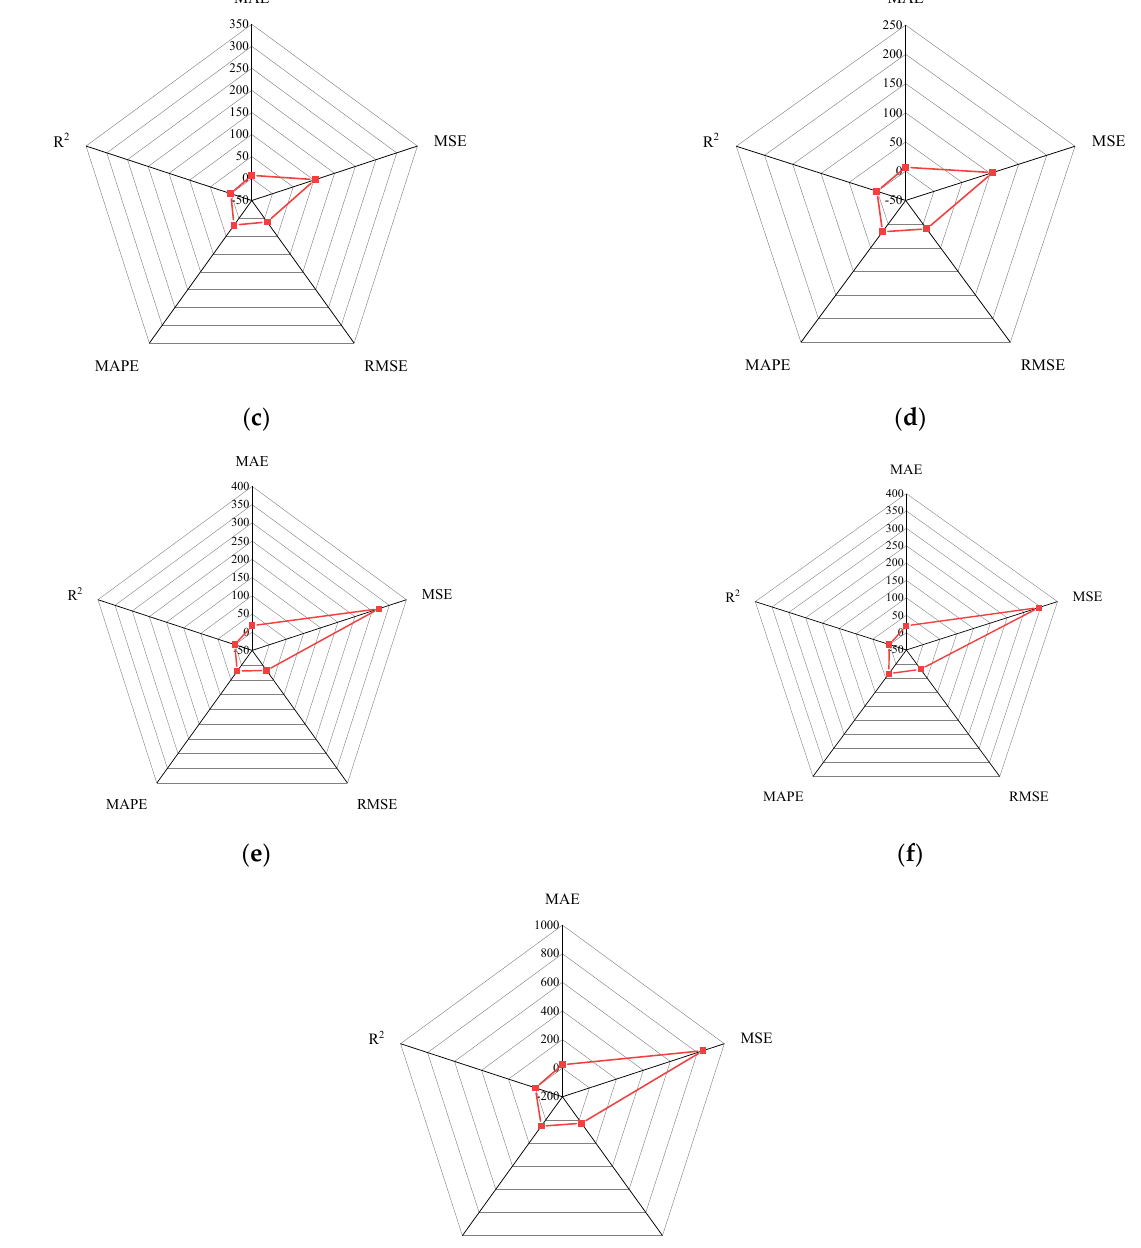
Figure 15. Radar diagram of calculation results. ( a ) BP neural network; ( b ) GA-BP neural network; ( c ) Optimized BP neural network; ( d ) Optimized GA-BP neural network; ( e ) ACI-318-14; ( f ) BS-8110; ( g ) TBC-500-2000.